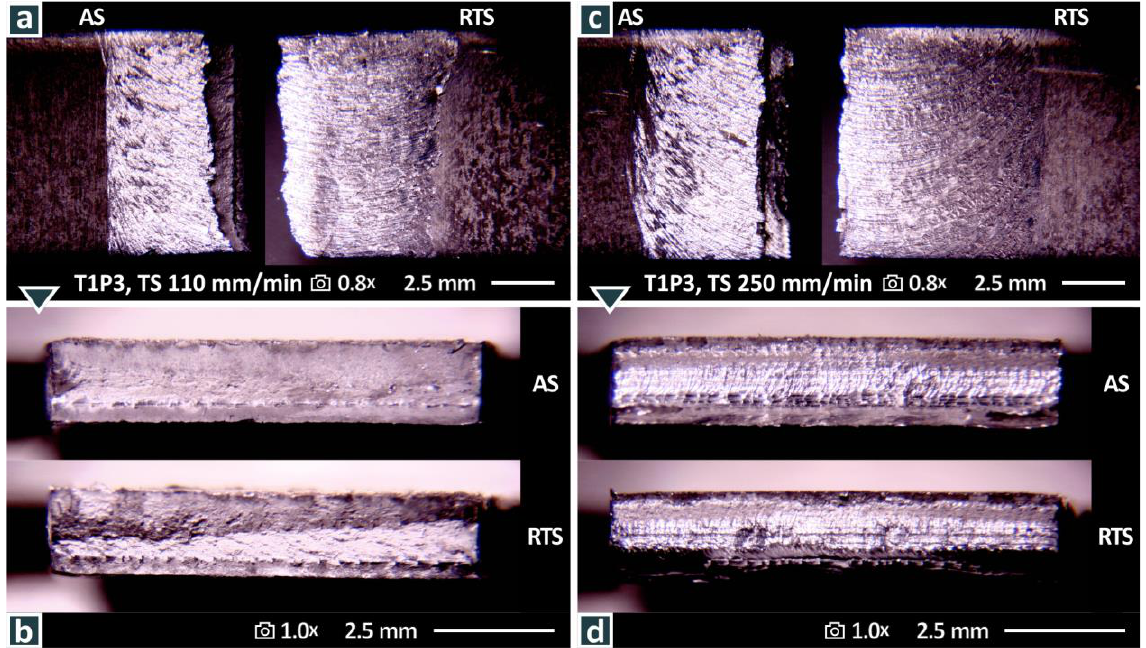
Figure 10. Stereoscopic microscopy images for the T1P3 weld tool at weld speeds of 110 mm/min: ( a ) top surface, ( b ) fracture surface; and 250 mm/min: ( c ) top surface, ( d ) fracture surface.